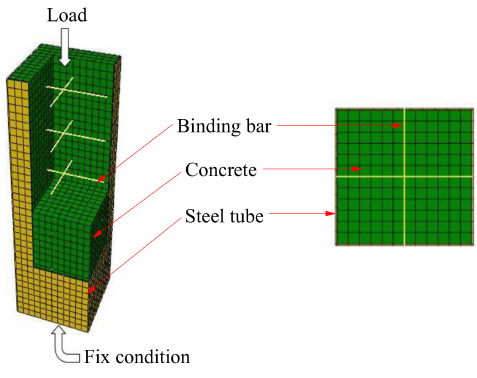
Figure 8. Boundary conditions and element